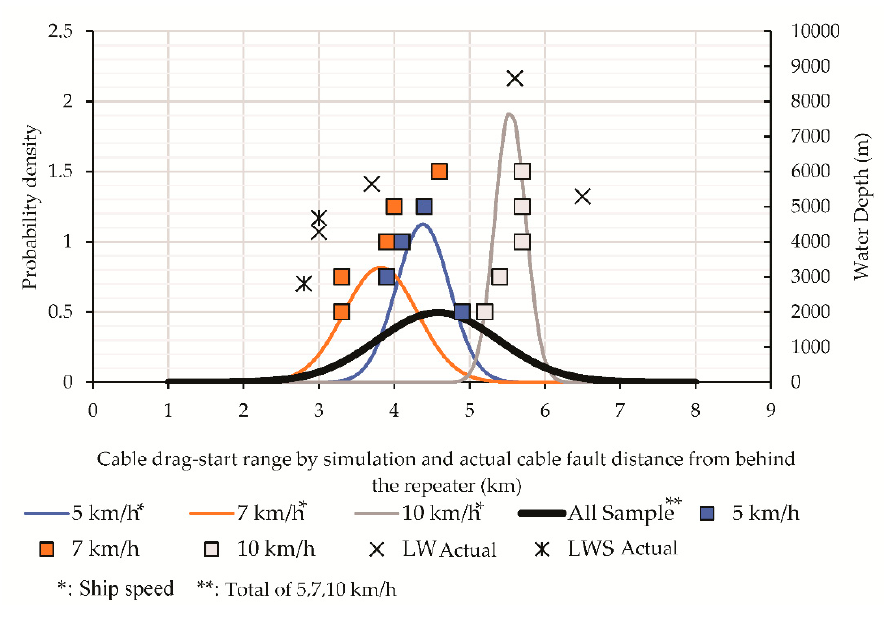
Figure 19. Comparison of the normal distribution of the cable drag-start range behind the repeater simulated in Section 3.4.3 (see Figure 13) with the actual cable fault